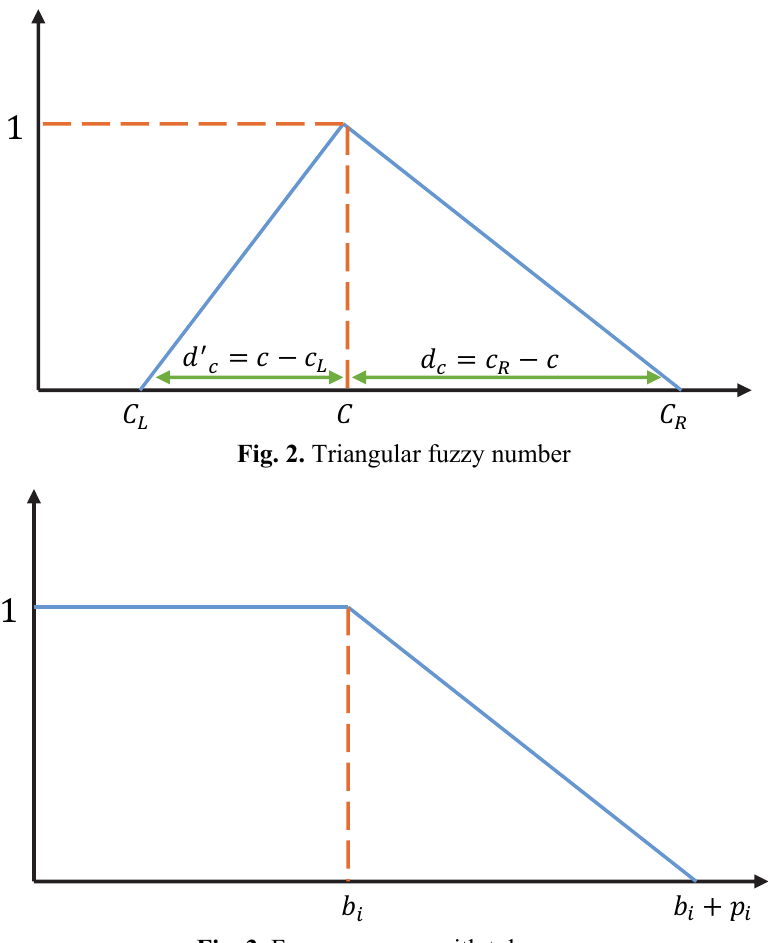
Fig. 2. Triangular fuzzy number